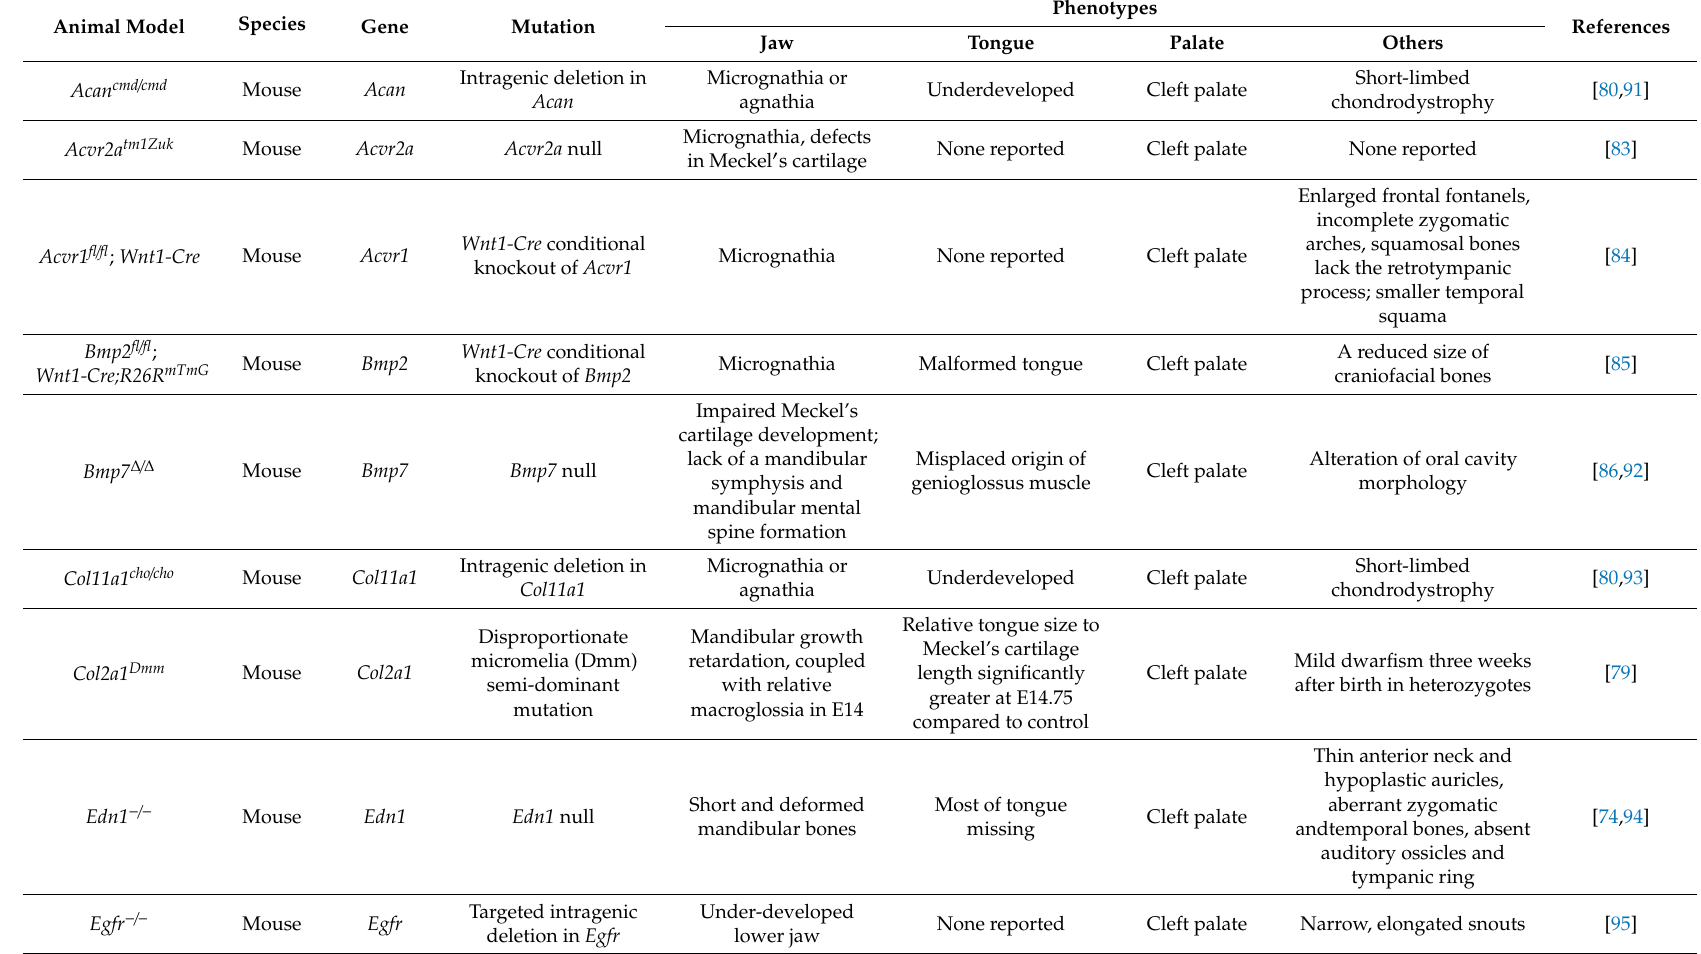
Table 2. Select animal models for PR